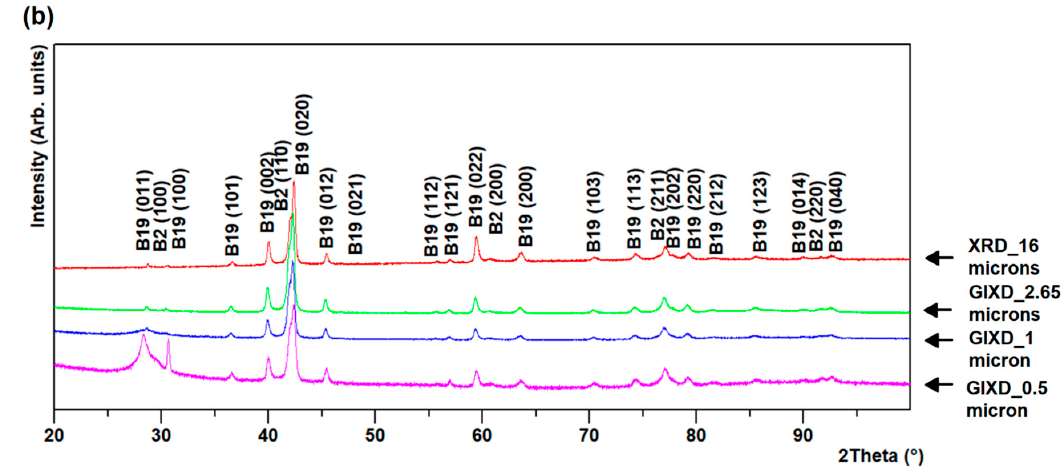
Figure 2. Grazing incidence di ff raction (GIXD) for R96 ribbon ( a ) air- and ( b ) wheel-side.